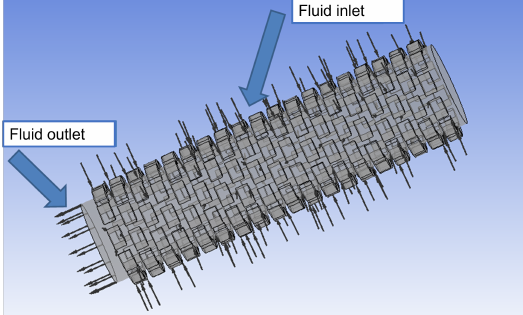
Figure 12. Determination of fluid inlet and